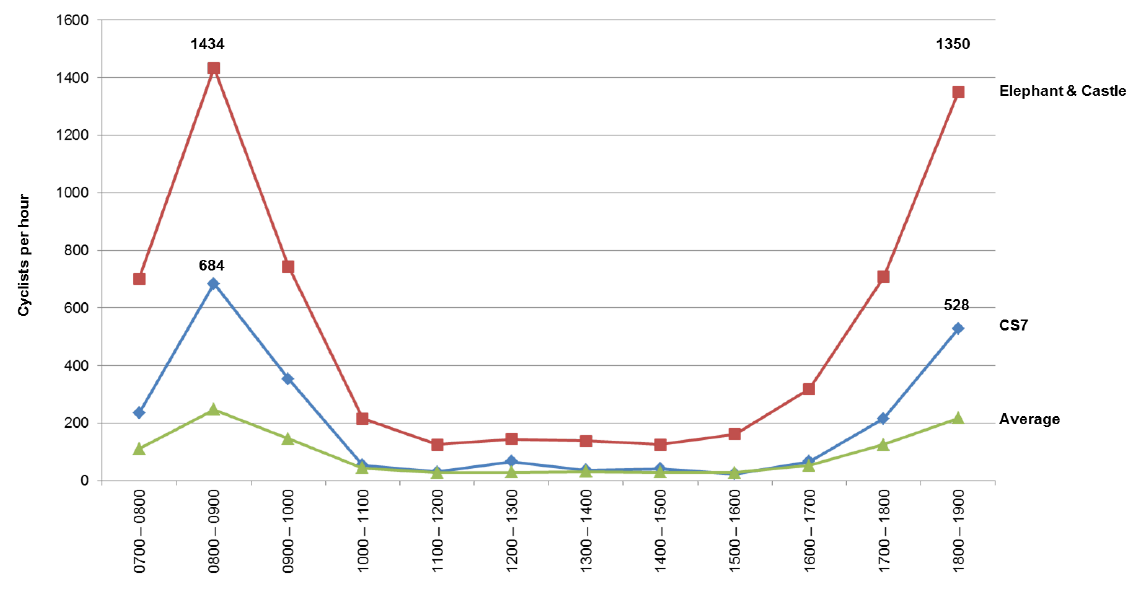
Figure 10. Cyclist movement distribution across the time comparison.